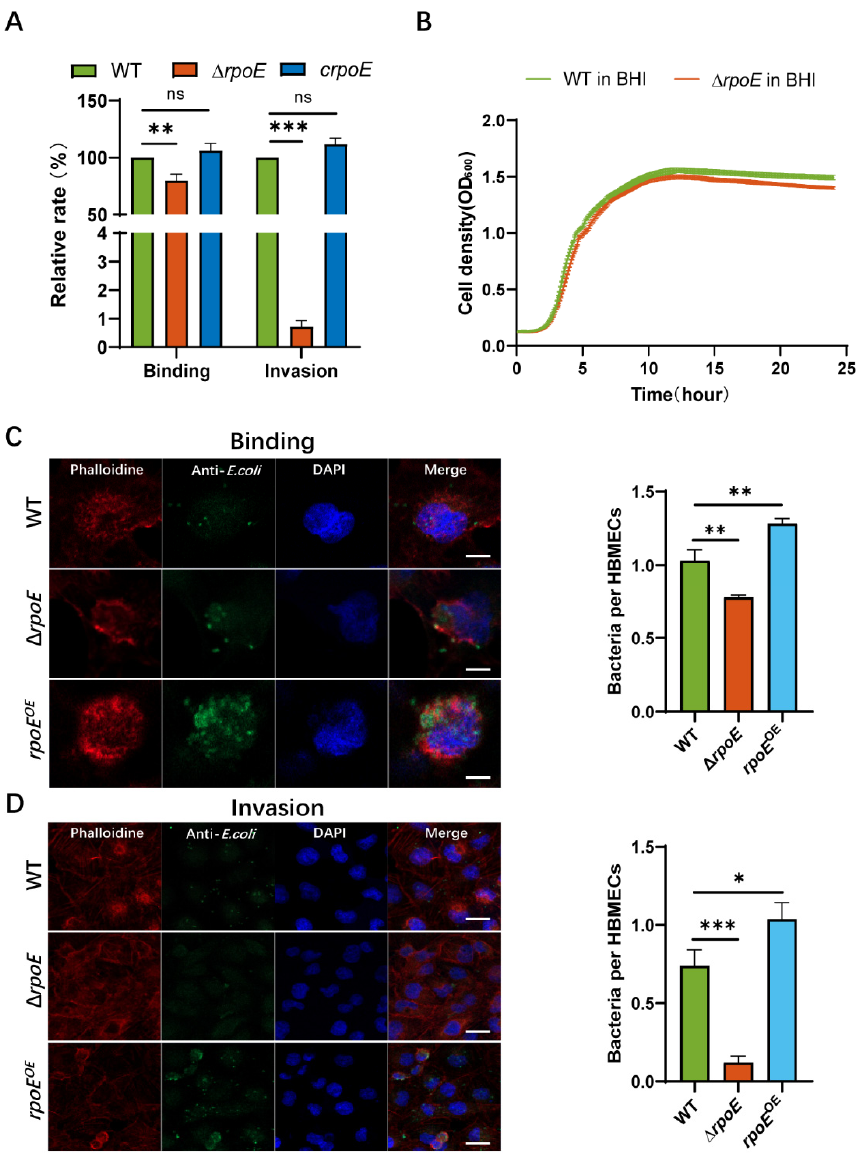
Figure 1. Deletion of rpoE reduces Escherichia coli K1 binding to and invasion of human brain microvascular endothelial cells (HBMECs). ( A ) The binding and invasion abilities of ∆ rpoE and crpoE strains were calculated relative to those of the wild-type (WT) strain. ( B ) Growth of RS218 WT and ∆ rpoE strains in brain-heart infusion (BHI) medium. ( C ) Number of bacterial cells per each HBMEC determined in random fields of fluorescent actin staining (FAS) in a binding assay. Average of at least 50 cells is shown (left). Scale bar, 5 µ m. ( D ) Number of bacterial cells per HBMEC determined in random fields of FAS in an invasion assay. Average of at least 50 cells is shown (left). Actin cytoskeleton (red) and nuclei (blue) of the HBMECs, and bacterium (green) are shown. Scale bar, 20 µ m. * p < 0.05, ** p < 0.01, *** p < 0.001 by Student’s t -test. ns, not